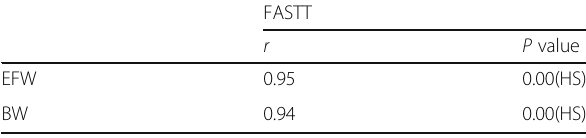
Table 1 Correlation between FASTT and EFW as well as BW